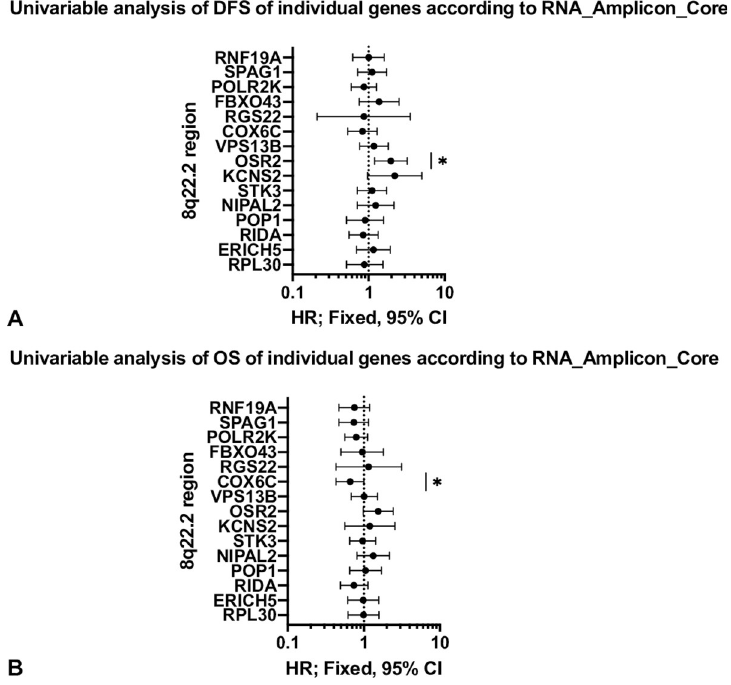
Fig 2. Univariable analysis of OS and DFS of individual genes according to RNA_AMP_Gene. (A) Forest plot depicting hazard ratios (HR) with 95% confidence intervals (95% CI) of DFS of RNA_HIGH_Gene versus RNA_LOW_Gene. Genes of the 8q22.2 region are arranged according to their genomic location on 8q22.2. � indicates a p-value of 0.01. (B) Forest plot depicting hazard ratios (HR) with 95% confidence intervals (95% CI) of OS of RNA_HIGH_Gene versus RNA_LOW_Gene patients. Genes of the 8q22.2 region are arranged according to their genomic location on 8q22.2. � indicates a p-value of 0.04.